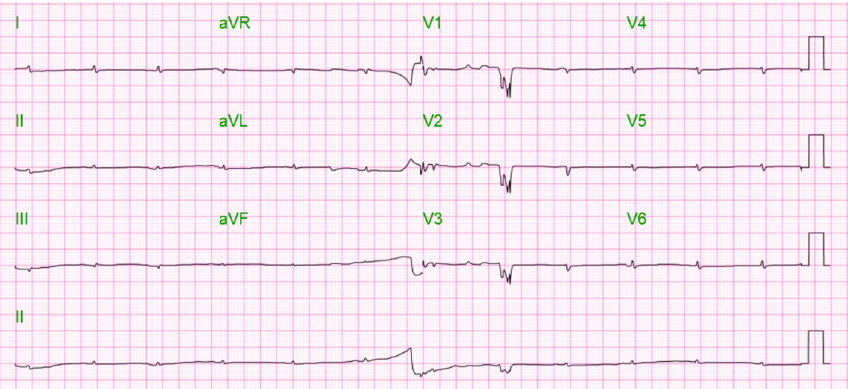
Figure 1: Electrocardiogram at presentation showing a sinus rhythm with a heart rate around 90bpm and di ff use low voltage in both precordial and limb leads.